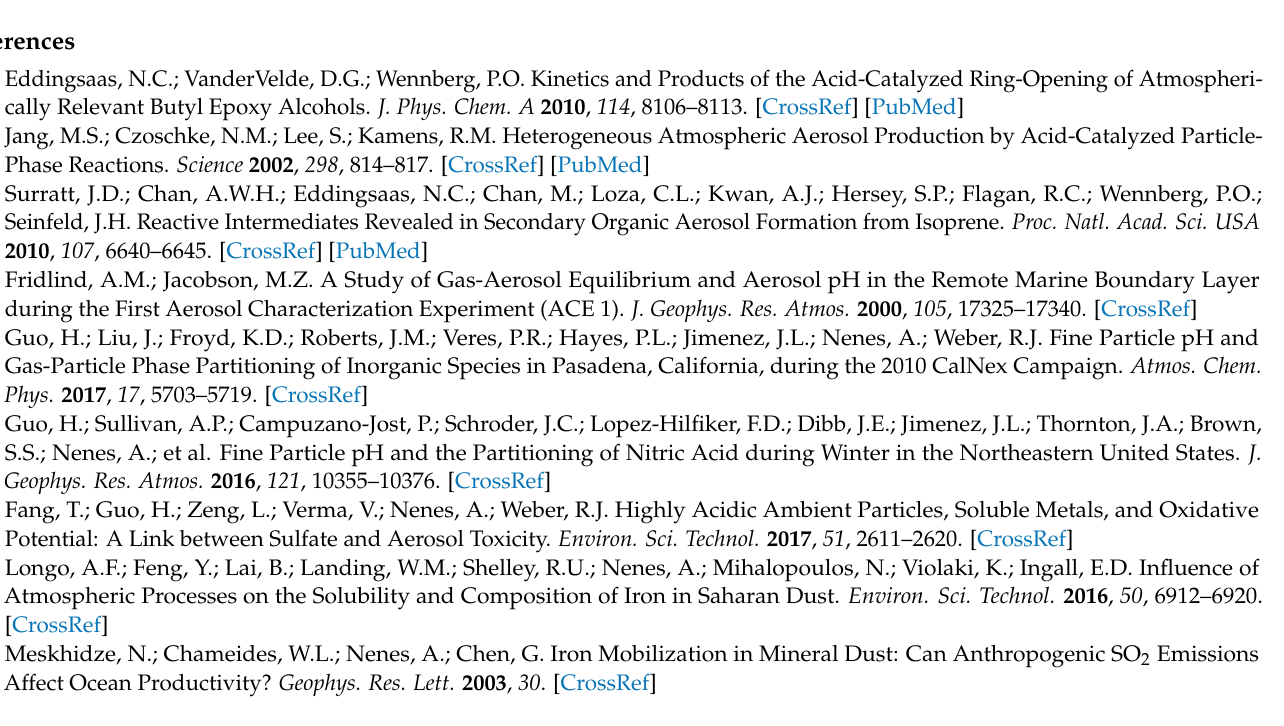
Figure S2: Box plots depicting the median (a) H + , and (b) W i values calculated by ISORROPIA-II air for the different concentrations of gas-phase HNO 3 added into the system. Figure S3: Box plots of W i vs. (a) SO 42 − , and (b) RH. Figure S4: Box plots depicting the median (a) pH, (b) H + , and (c) W i air values calculated by ISORROPIA-II where crustals were treated explicitly vs. as mole-equivalent Na + . Figure S5: Box plots depicting the median (a) H + , and (b) W i values calculated by ISORROPIA-II air for internally mixed aerosols vs. the aerosol mode containing only non-sea salt species. Table S1: Average mass concentrations of chemical species measured by the PILS-fraction collector system. Table S2: Sensitivity of H + and W i to SO 42 − , TA (NH 3 + NH 4+ ), Na + , Ca 2+ , K + , Mg 2+ , RH, and air